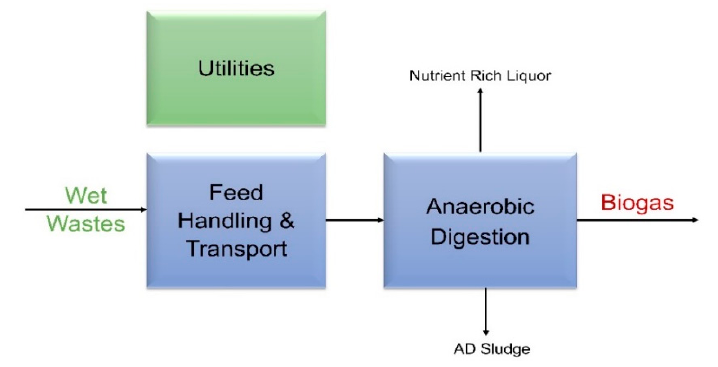
Figure 3. Process Flow Diagram for Modeling AD using Aspen Plus.